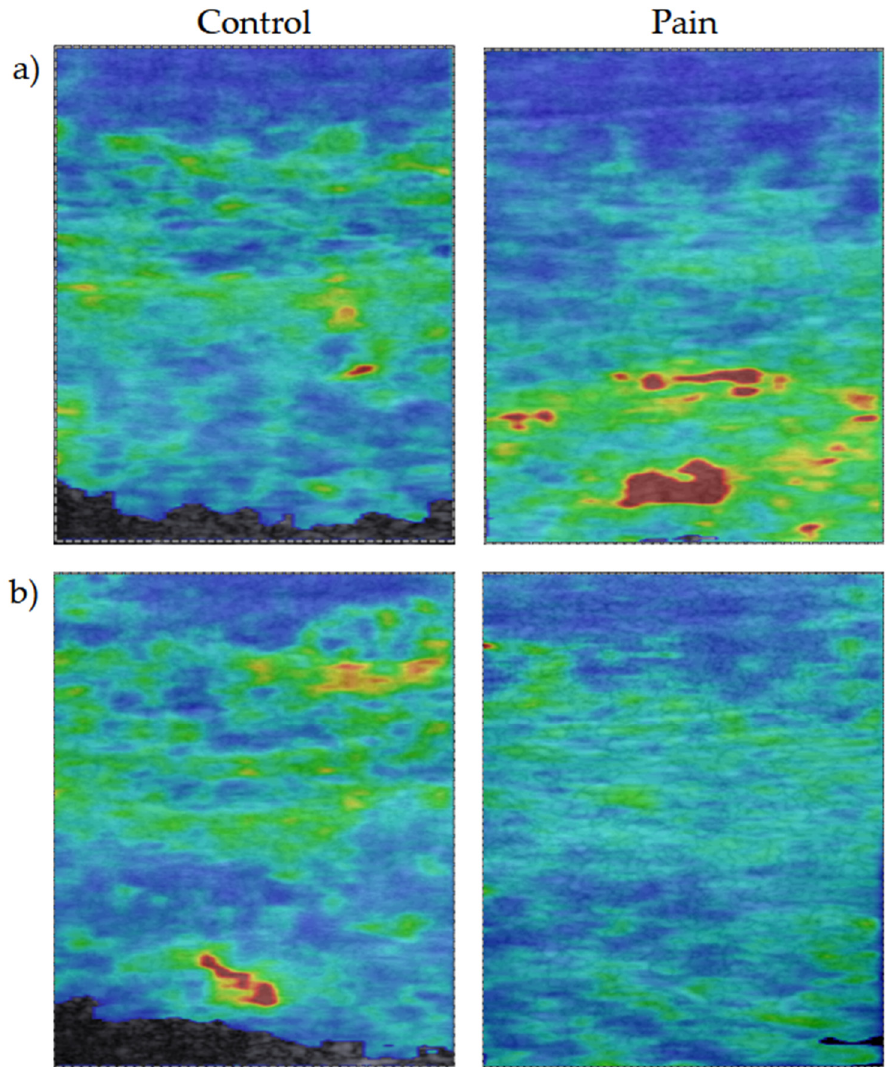
Figure 2. A sample of shear wave elastography images from the control and pain group, recorded during neck extension while lying prone; ( a ) The difference between classes is visually detectable, with increased stiffness in the bottom part of the image from the pain group; ( b ) The assigning to both classes by visual inspection is challenging.